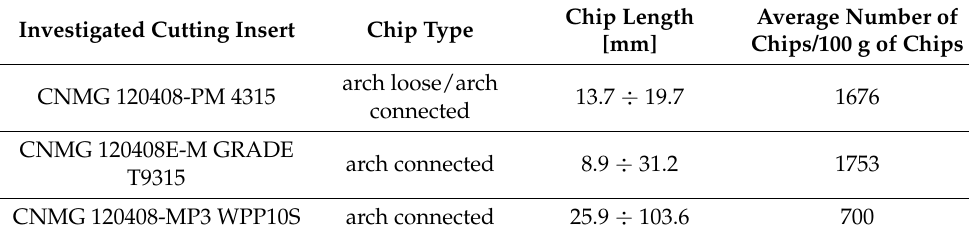
Table 3. Comparison of produced chips for individual cutting